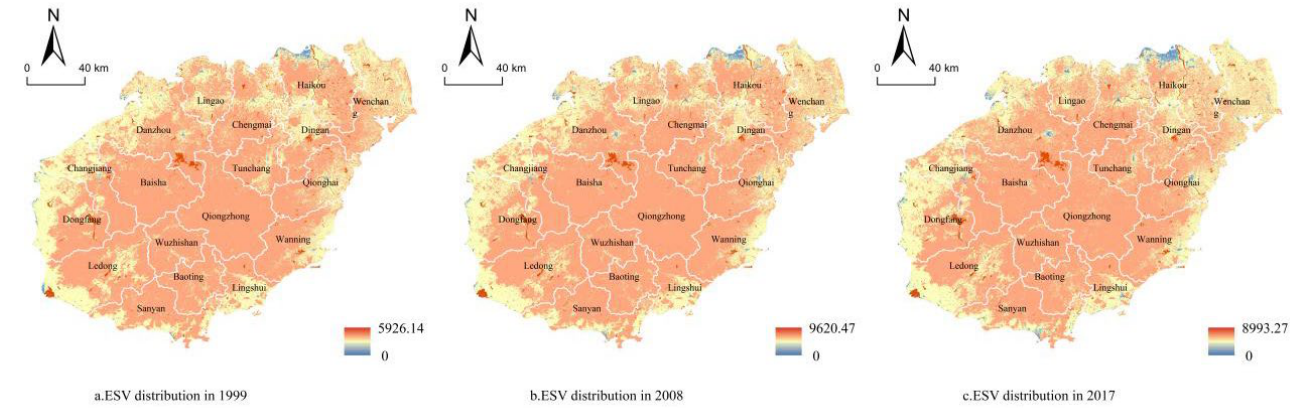
Figure 4. Spatial evolution of ESV in Hainan Island from 1999 to 2017.